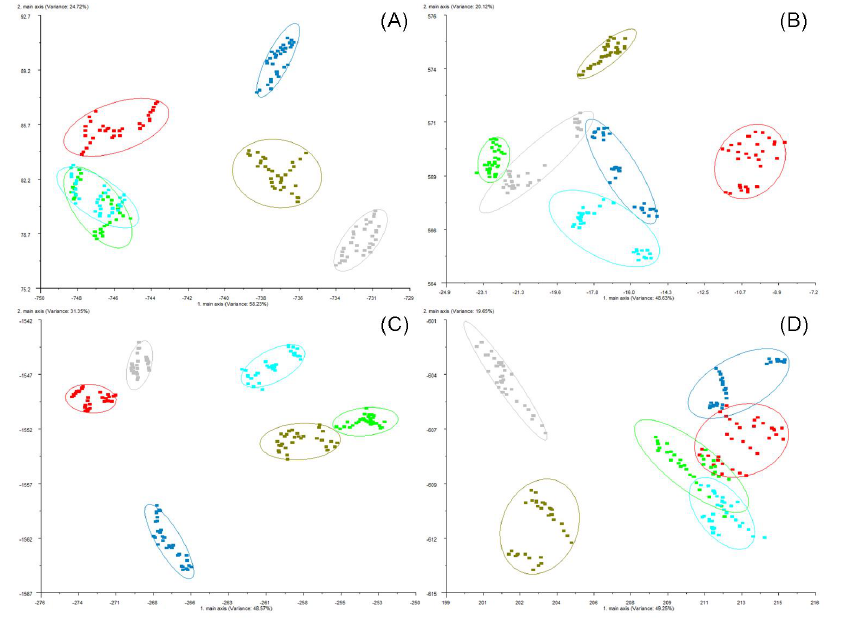
Figure 7. Aroma map plots based on LDA of volatiles from healthy and decayed wood blocks of (A) Acer negundo , (B) Acer saccharinum , (C) Castanea sativa , (D) Cedrus deodara , (E) Celtis australis , (F) Platanus x acerifolia , (G) Quercus rubra and (H) Robinia